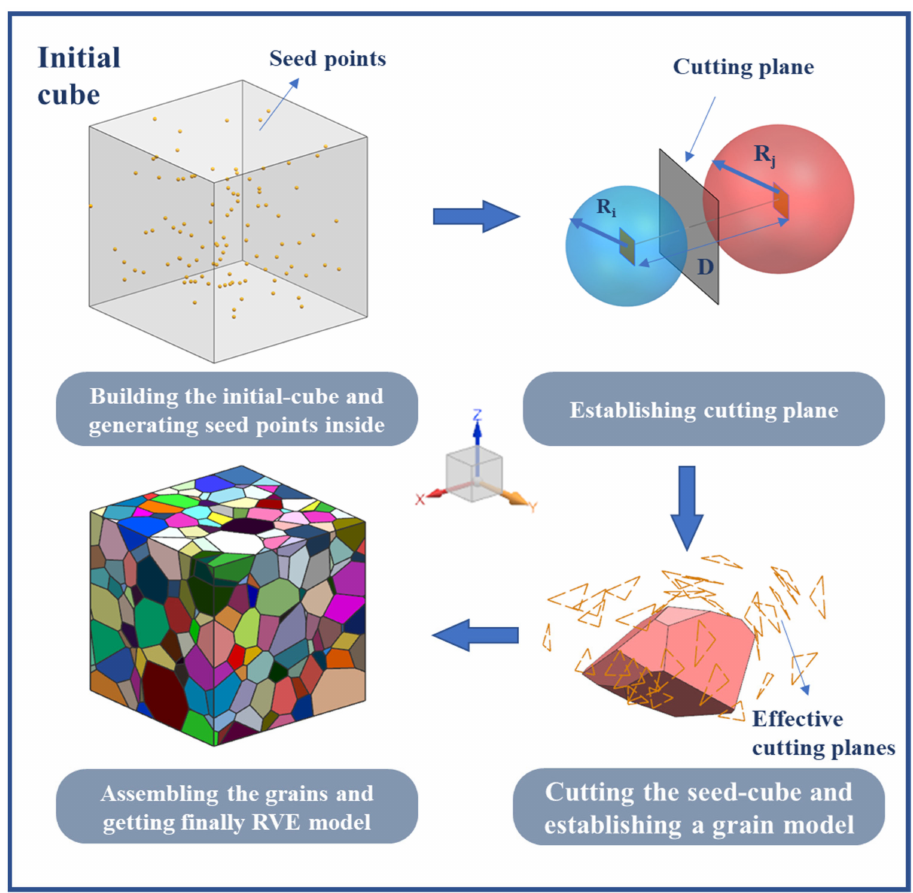
Figure 2. Flow chart of polycrystal modeling.